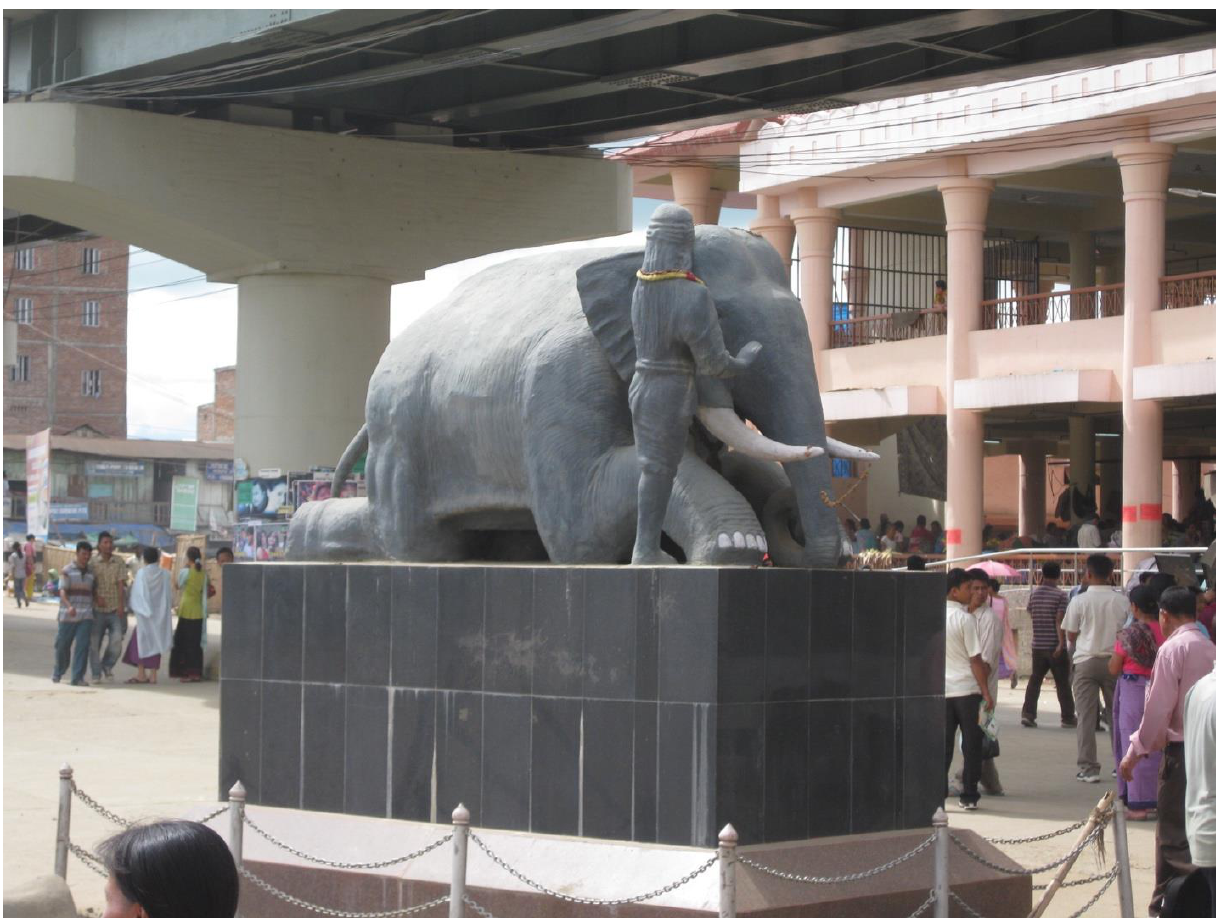
Figure 1. A statute of Bhāgyacandra mounting the elephant is displayed in a marketplace. After Bhāgyacandra’s legendary victory, thousands of people volunteered to help him in his quest to regain his throne (N. T. Singh 2007, p. 39). In 1767, after an initial failed expedition due to his troops getting lost (Bhuyan 1933, pp. 59 – 60), a military force of 80,000 Assamese soldiers armed with guns, swords, and spears were sent to Manipur to assist Bhāgyacandra (Sana 2010, p. 145). It succeeded in restoring Bhāgyacandra back to the throne and his triumphant return to Manipur is recorded in the CK. 57 Bhāgyacandra was then recognized as the supreme ruler of Manipur, both by the people of the valley and the various tribes of the hill (N. T. Singh 2007, p. 42). By the late 1770s, after Bhāgyacandra regained power, one of his first acts was to reverse the practices that the Burmese introduced. When the Burmese occupied Manipur, they appointed Chandragya as governor of Manipur. According to the CK, Chandragya suppressed Hindu practices and forced the Meiteis Vais.n. avas to remove their sacred thread. 58 In 1781, Bh¯agyacandra organized a ceremony in which he directed the Meiteis who were forced to remove their thread to wear it again.